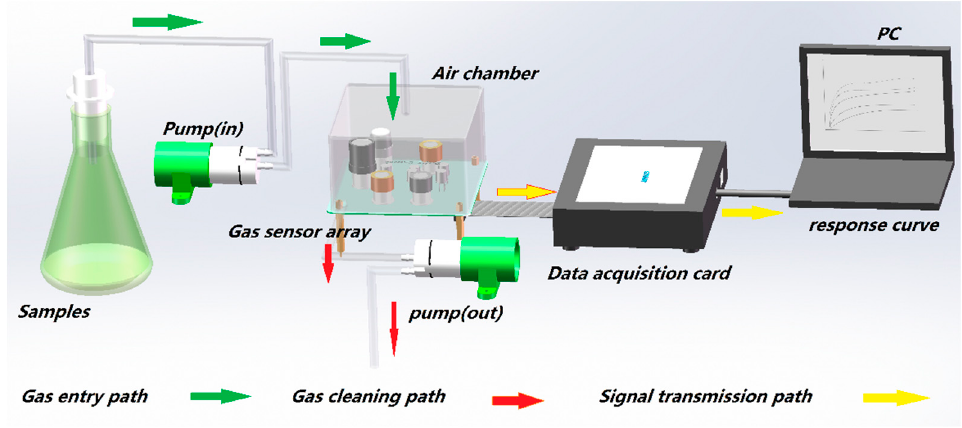
Figure 2. Data acquisition process of Chinese liquors based on electronic nose.